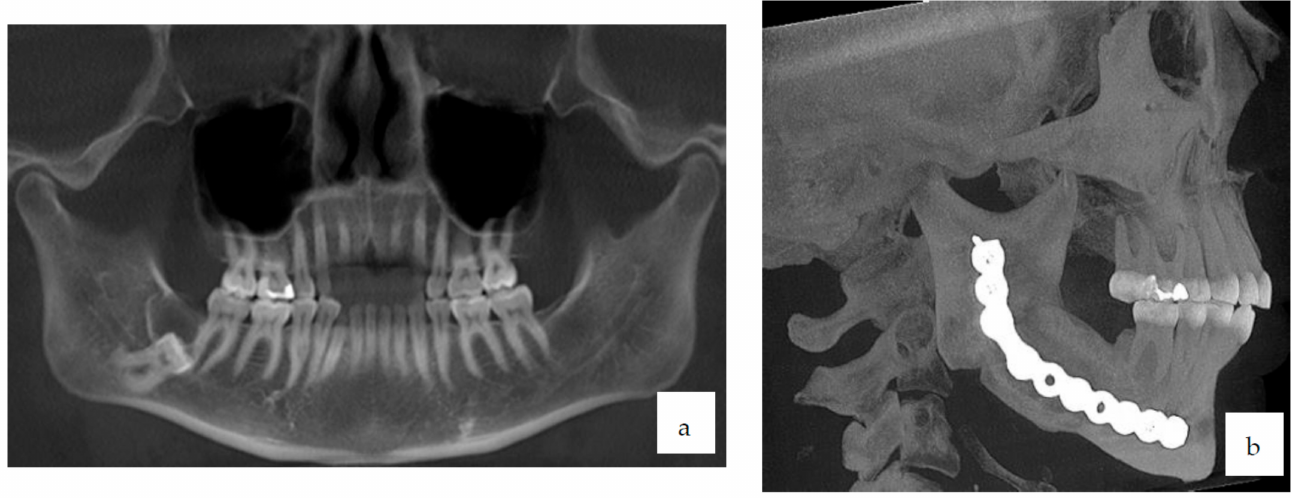
Figure 1. ( a ) Preoperative panoramic radiography; ( b ) cone beam computed tomography 3 years after